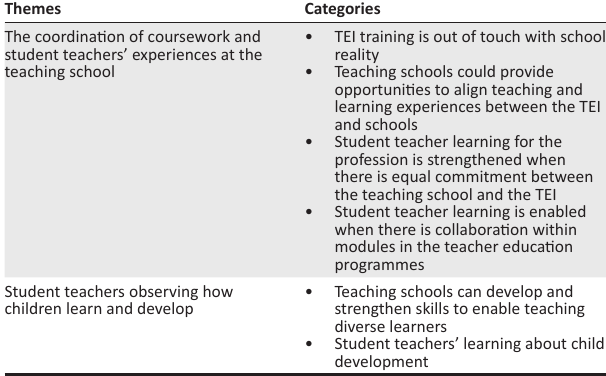
TABLE 2: Themes and